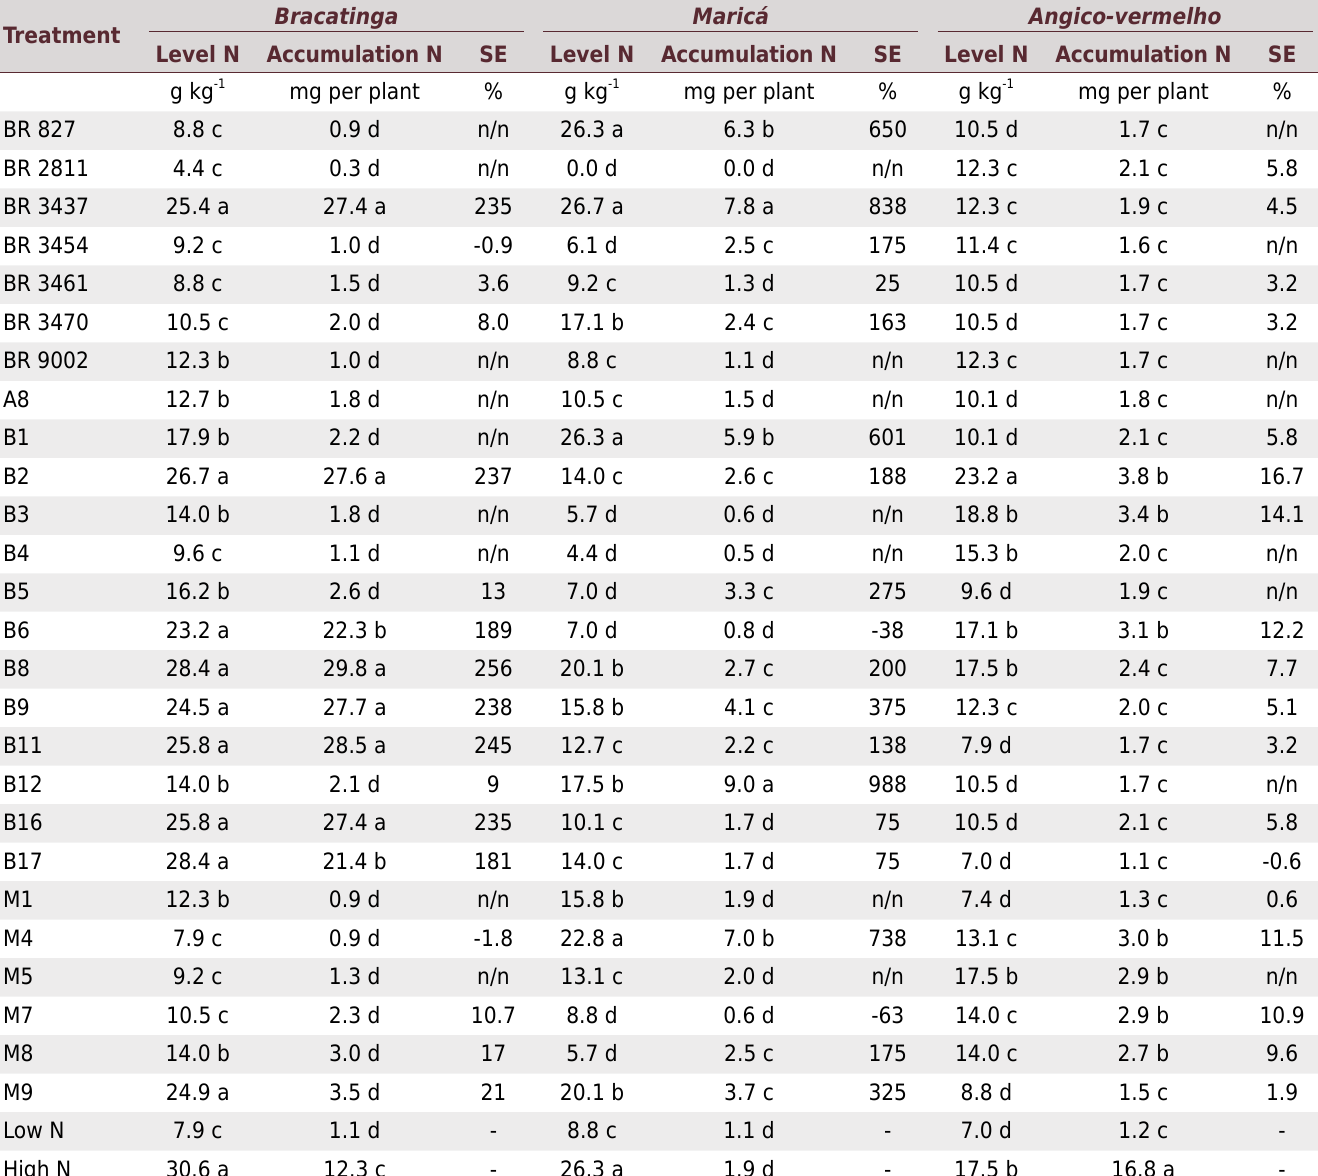
Table 1. Symbiotic efficiency (SE) of isolates and contents and accumulation of N in the shoots of leguminous tree species inoculated with rhizobia isolated from coal mining areas, in comparison to recommended strains of